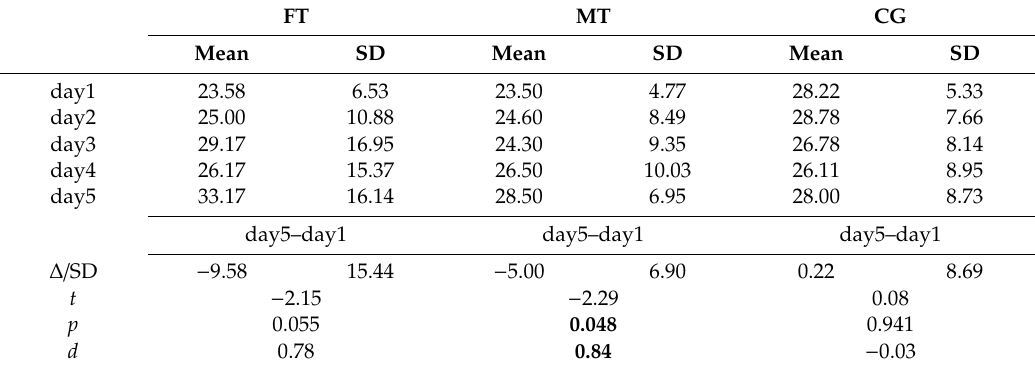
Table A5. Mean values and e ff ect sizes for Deck C within groups.